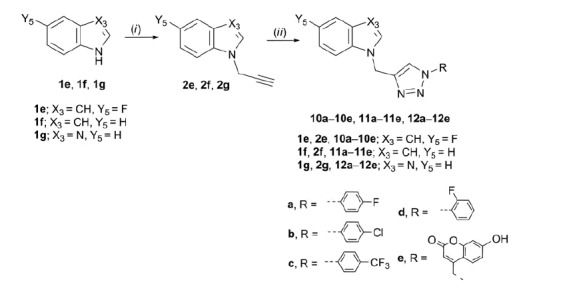
Synthesis of novel benzimidazole and indole derivatives with N-1 substituted 1,2,3-triazole. Reagents and conditions: (i) propargyl bromide, NaH, DMF, Ar atmosphere, 60 °C, 24 h; (ii) corresponding azide, Cu, 1 M CuSO4 solution, tert-butanol: H2O = 1: 1, MW 300 W, 80 °C, 45 min.